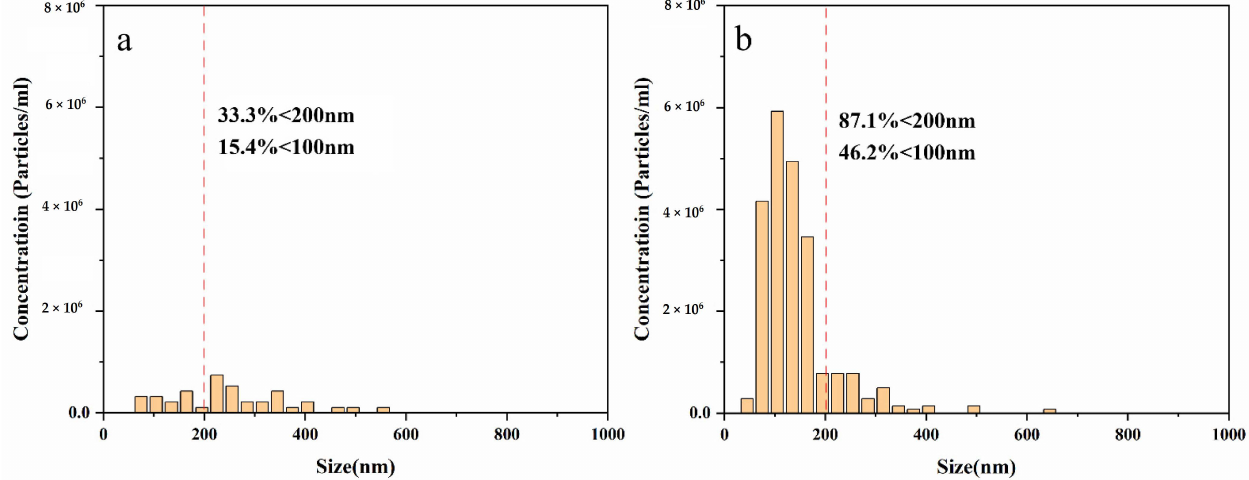
Figure 2. Nanoscale bubbles size and distribution in macrobubble treatment control system ( a ) and nanobubble treatment system ( b